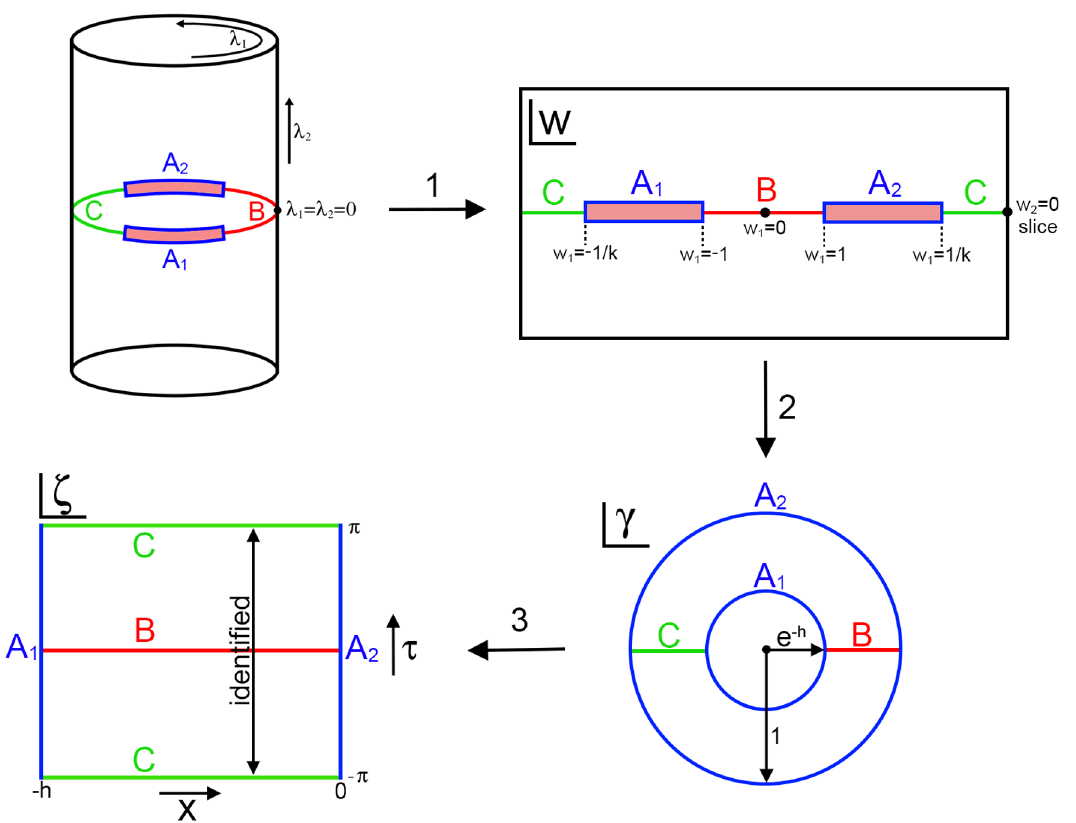
¯ λ coordinates with slits at {− ‘/ 2 − s <